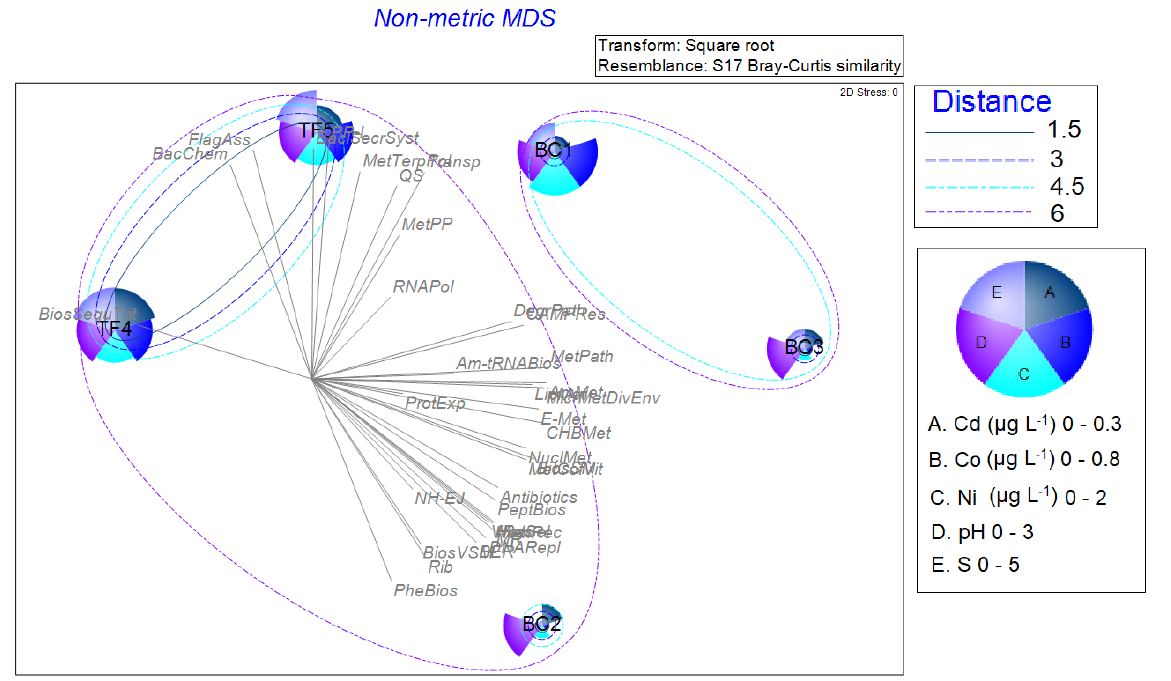
Figure 8. Non-metric multidimensional scaling analysis computed on normalized biological data (enzymatic activities, microbiological data, archaeal and bacterial community composition, and predictive analysis), by superimposing the cluster analysis performed on the physicochemical results. The bubble plots show the parameters having the most influence on the multidimensional scaling, as determined by the BEST Spearman rank correlation test.